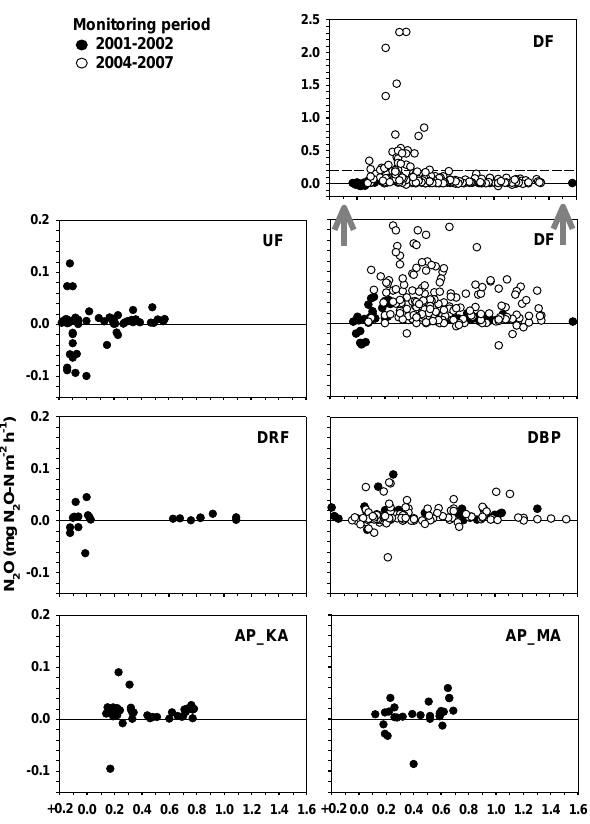
Fig. 2. N 2 O fluxes (mg N 2 O-N m -2 h -1 ) at various water table depths (m). Different forms in circles (if applicable) refer to different gas flux monitoring periods. Two panels are provided for the DF site, one with equal scale to the other sites and one with wider scale (panel which shows all data for the DF site is pointed at by arrows and dotted line in it denotes upper scale limit of the other panels). Site type codes are defined in Fig. 1 and Table 1.